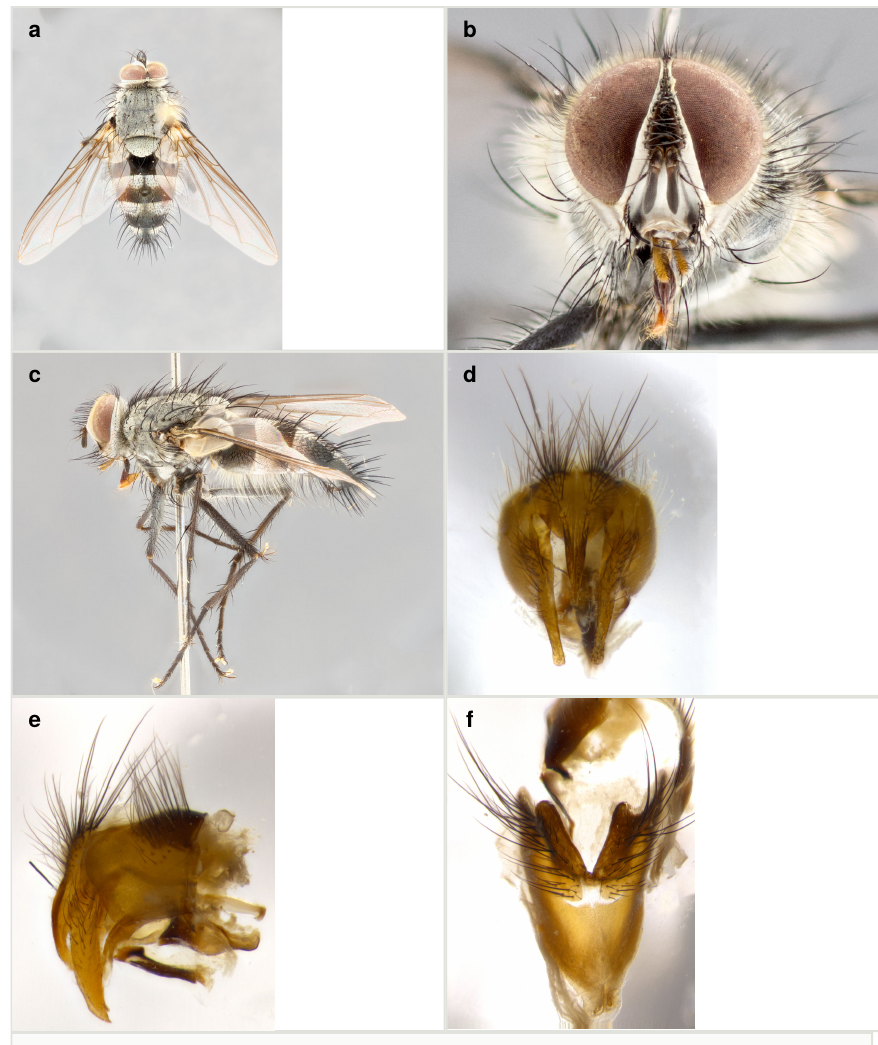
Uramya albosetulosa sp. nov. ; a-c : holotype male; voucher n. DHJPAR0018602; d-f : paratype male; voucher n.